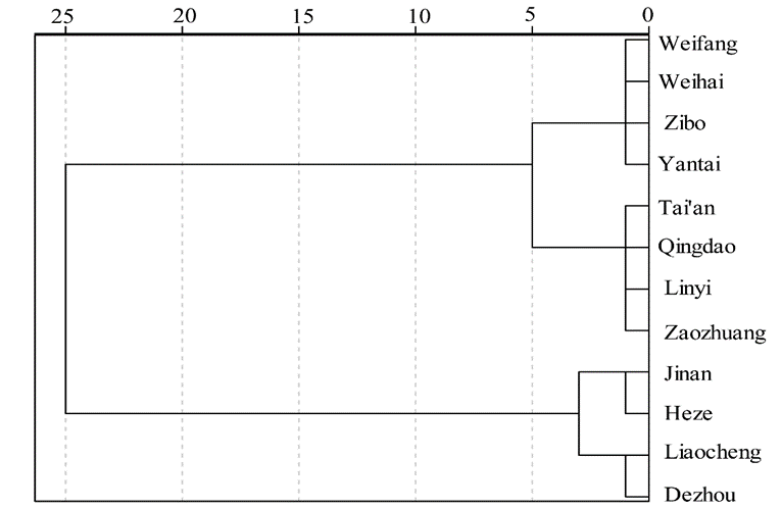
Figure 3. The cluster analysis of studied cities on the concentration of Cr.